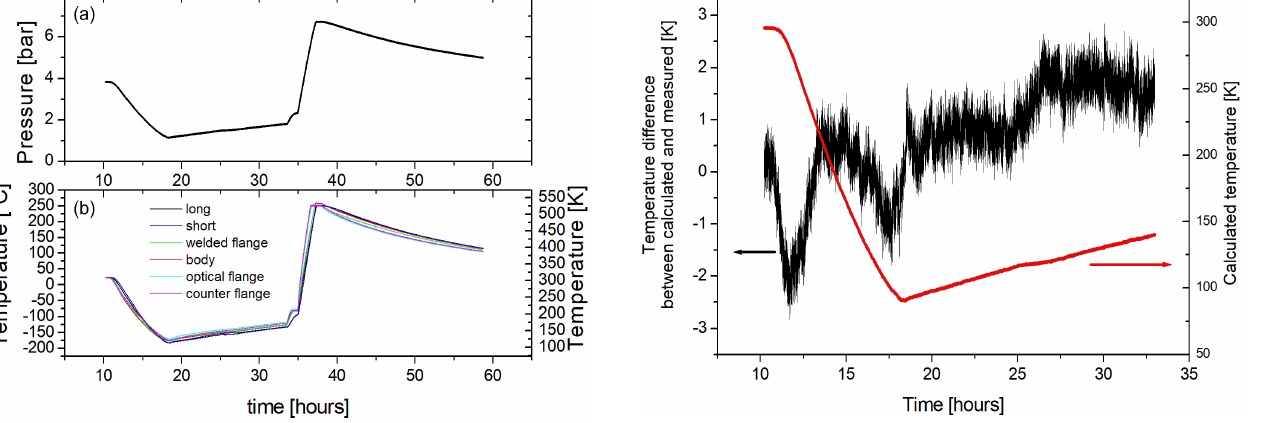
Figure 6. Cooling and heating test of PASS x S with about 3.7 bar of argon in the sample chamber at room temperature. (a) The pressure of the Ar is indicated in bar. (b) The blue and black curves refer to the temperatures recorded by the short and long thermocouples put inside the inner cell (6 and 5 in Fig. 2). The light blue, green, violet, and purple curves refer to the temperatures acquired by the other thermocouples (4, 3, 2, and 1 in Fig. 2).